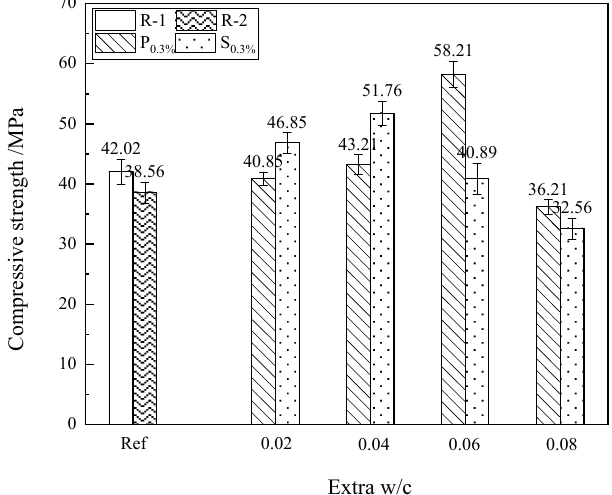
Figure 6. Compressive strength of cement mortar with different entrained water-to-cement ratio (w/c) values.